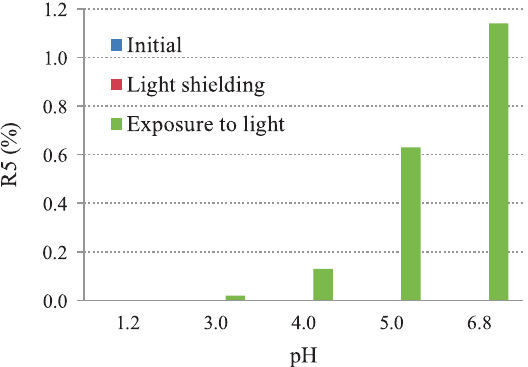
Fig. 3 Solid-state NMR spectra of risperidone and samples a)~d).